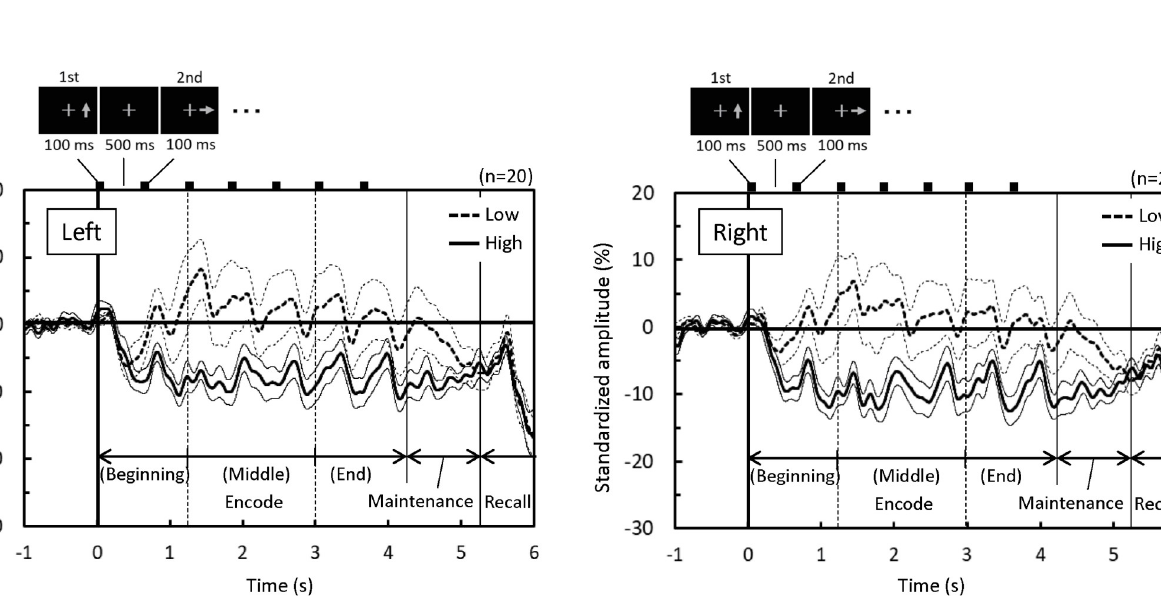
PLOS ONE | https://doi.org/10.1371/journal.pone.0239577 September 28,